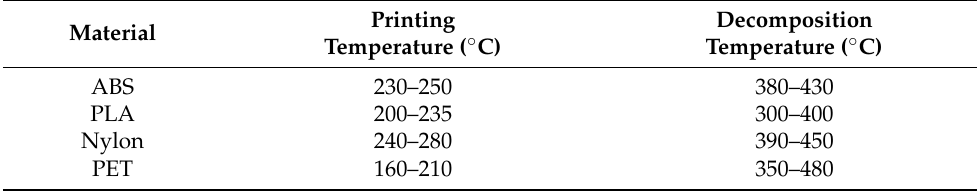
Table 1. Printing properties of the materials [3].